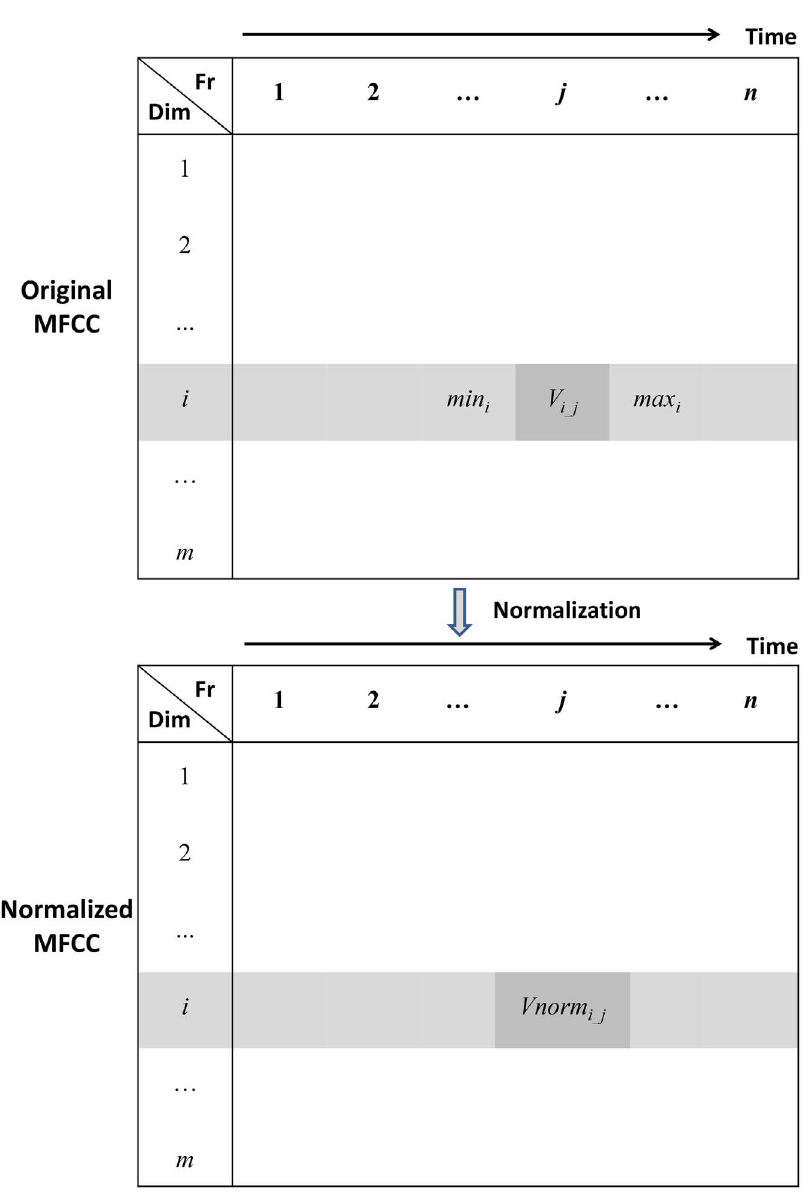
Figure 2. The illustration of MFCC normalization. In table header, ‘Fr’ represents time frame, and ‘Dim’ means dimension. A MFCC is represented by a n (cid:2) m matrix. This matrix is constituted by n time frames where each time frame is represented by a m dimensional vector. Therefore, each dimension has n values, which will be normalized into the range between 2 1 and 1 after the MFCC normalization step.